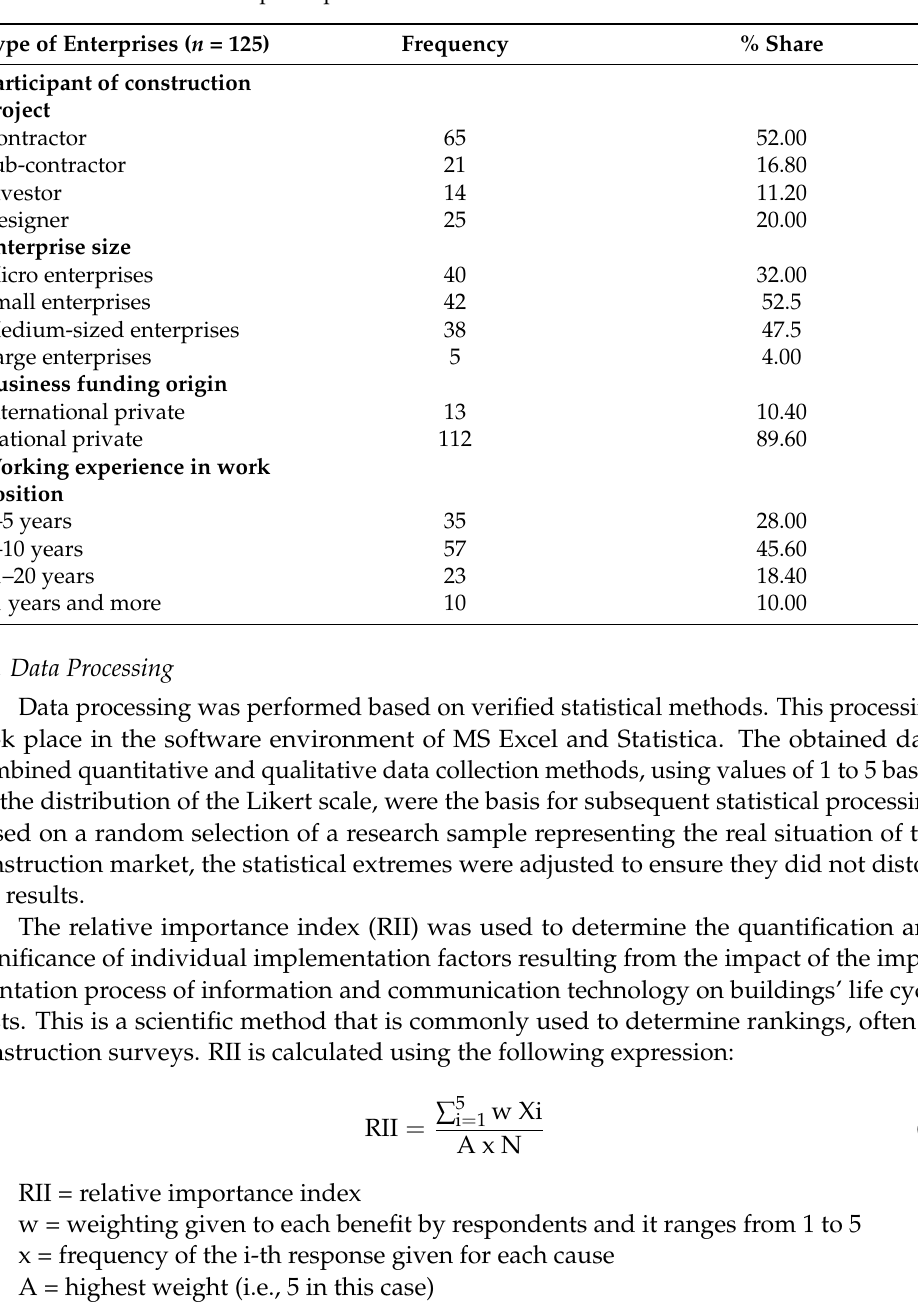
Table 4. Structure of research